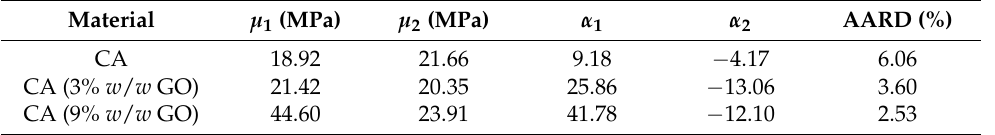
Table 5. Parameters and deviations for the Ogden model.